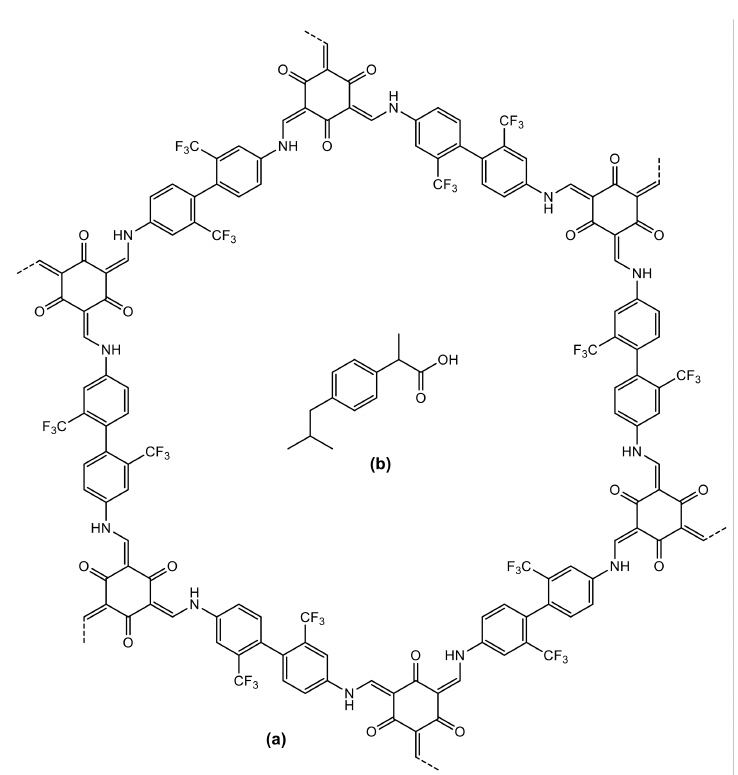
Figure 11. Structure of ( a ) TpBD(CF 3 ) 2 -COF and ( b ) ibuprofen